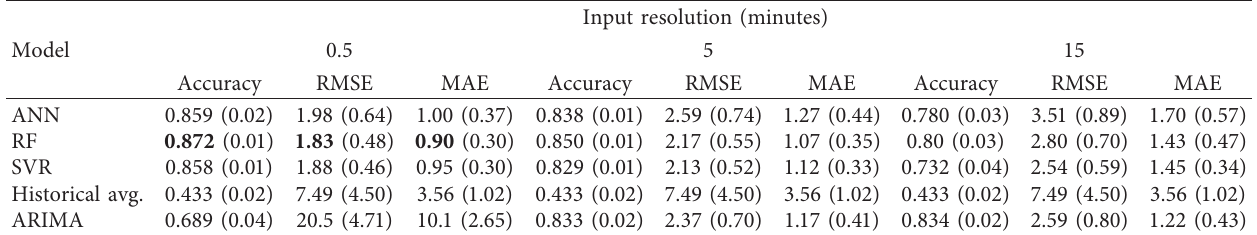
Table 3: Traffic occupancy prediction under all conditions.